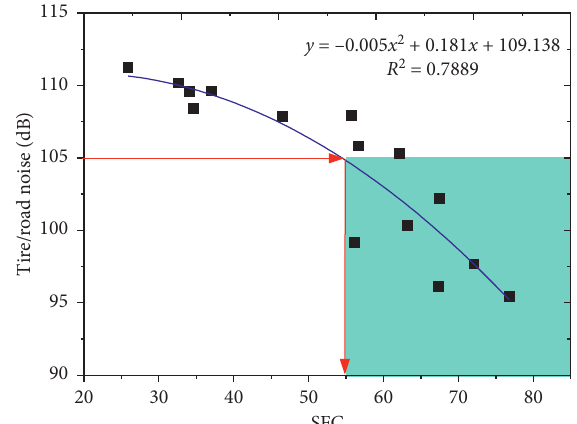
Figure 9: The analysis of correlation between pavement noise and antiskid